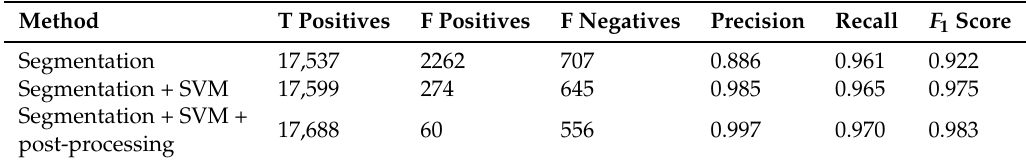
Table 2. The precision, recall and F 1 score metrics for panel detection in thermal images for three steps of our novel method based on classical techniques: segmentation, classification with a support vector machine (SVM) and after post-processing.